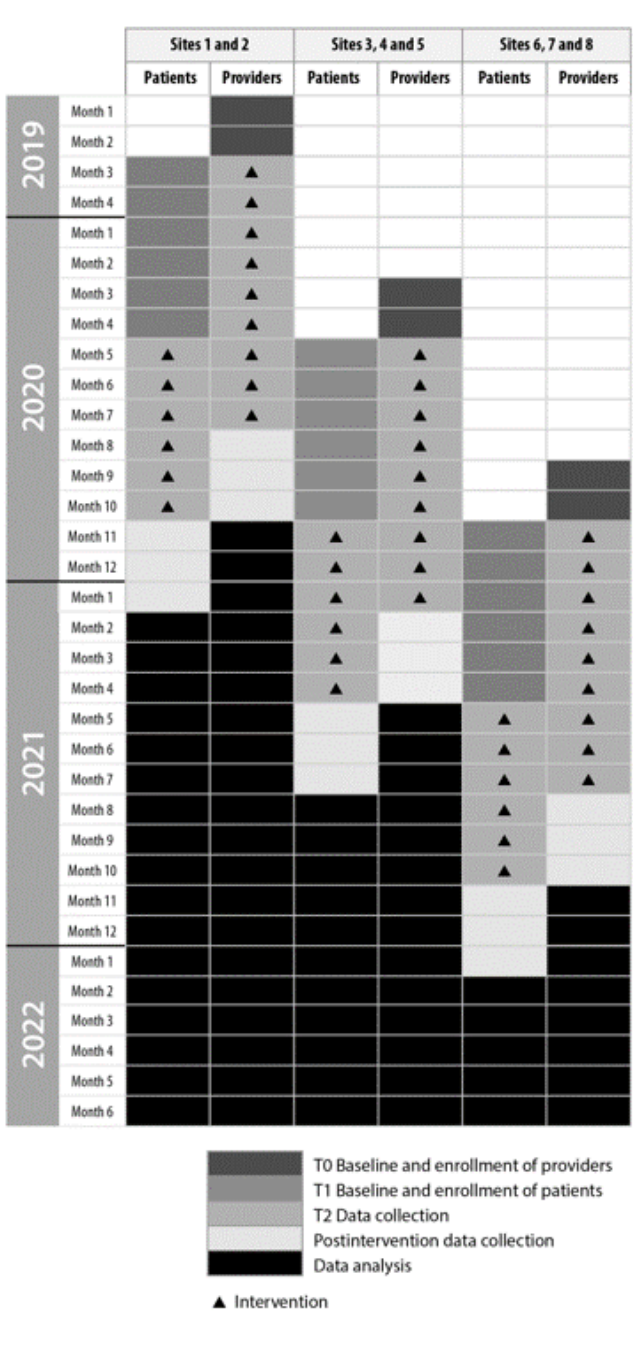
Figure 4. Study time periods: 2 or 3 groups of sites will enter the study at each of the 3 time periods, and 4 study phases will take place during each study period. T0: introduction of HU Toolbox to providers, provider enrollment, and baseline data collection. T1: introduction of InCharge Health to patients, patient enrollment, and baseline data collection. T2: All enrolled patients and provider participants were followed as active study participants. Each patient will use the InCharge Health app for 6 months, and each provider will use the HU Toolbox app for 9 months. Postintervention data collection: this phase reflects the sustainability of the interventions. We will continue to provide technical support for both patient and provider applications and measure continued utilization of the applications and adherence to hydroxyurea. Solid triangle denotes InCharge Health and HU Toolbox interventions. HU Toolbox: Hydroxyurea